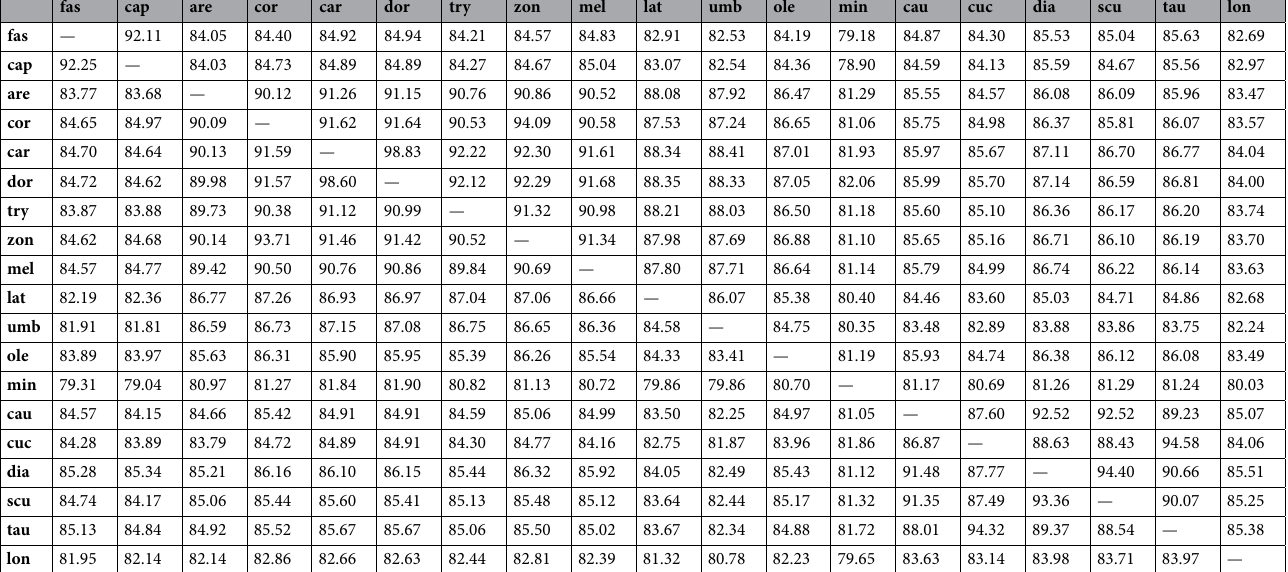
Table 3. Identity percentage matrix among 19 Tephritidae mitochondrial genome sequences. In the upper part the identities of complete mitochondrial DNA sequences are given. In the lower part the identities of the concatenated protein coding gene sequences are given. Species abbreviations and GenBank accession numbers of the mtDNA sequences used are given in Supplementary Τ able S1.